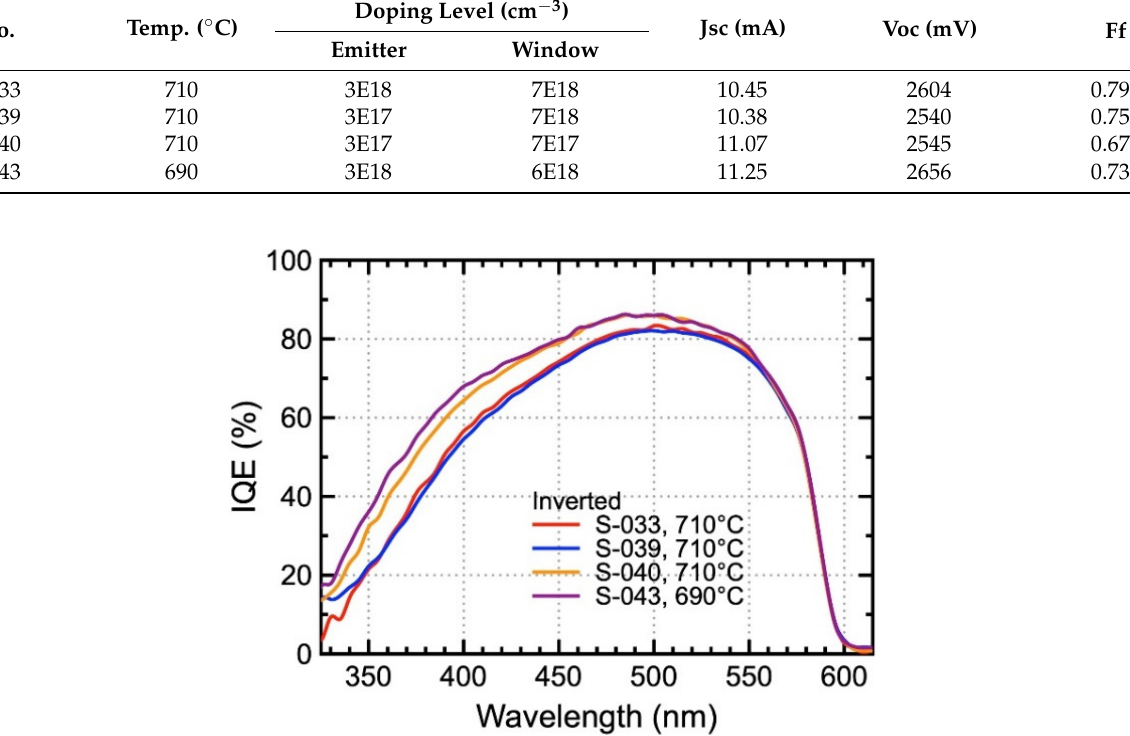
Figure 4. IQE curves of inverted 2.1 eV AlGaInP solar cells grown at 710 °C (S-033, S-039 and S-040) and 690 °C (S-043) with varied doping concentrations in emitter and window layer (detailed doping levels of samples are listed in Table 2). Reduced Si doping level in emitter has little effect on IQE, while reduced Si doping level in window causes an IQE recovery. In addition, Si-doped AlInP window layer grown at lower temperature results in better material quality and enhanced IQE. Table 2. Light J–V results of dual-junction solar cells (S-033, S-039, S-040 and S-043).